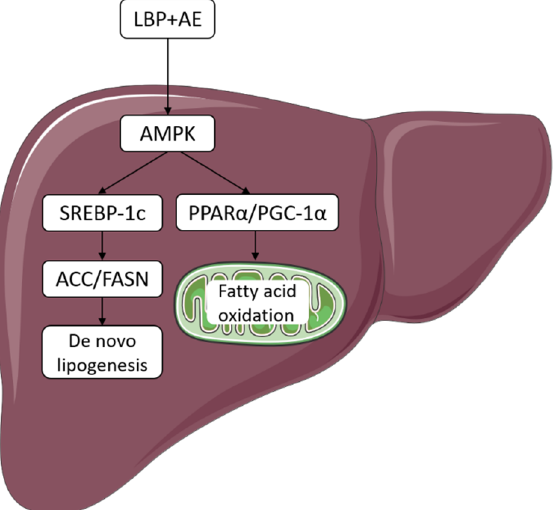
Figure 6. LBP plus AE improved NASH through AMPK activation and AMPK/PPAR α /PGC-1 α pathway. LBP plus AE activated AMPK to ameliorate NASH in two ways. On the one hand, the level of ACC and FASN decreased after SREBP-1c downregulation, thus inhibiting DNL. On the other hand, PGC-1 α and PPAR α can cooperate to promote FAO.